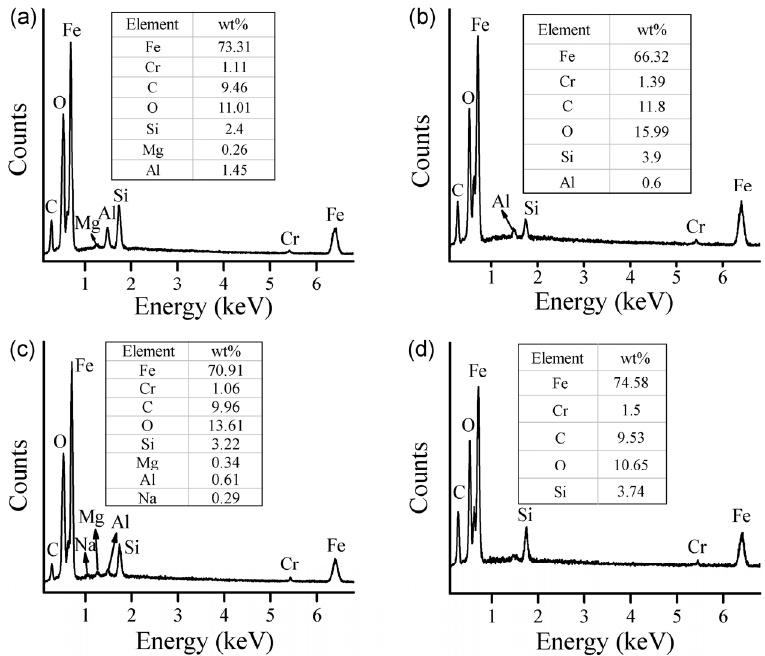
Fig. 9 EDS of the worn surfaces lubricated with insulating greases at 200 N, 5 Hz, and RT. (a) OMMT grease, (b) IOMMT grease, (c) MMT grease, and (d) SiO 2